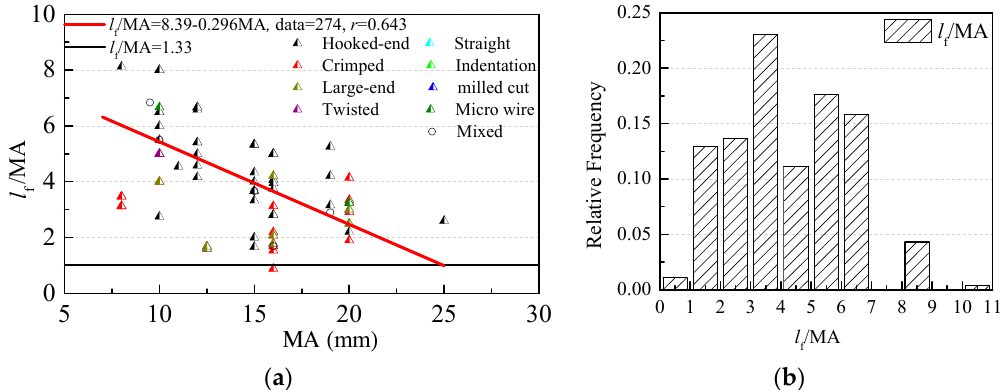
Figure 6. The relationship of fiber length l f and the maximum particle size of aggregates MA: ( a ) Variation of l f /MA along with MA; and ( b ) Probability distribution of l f /MA.